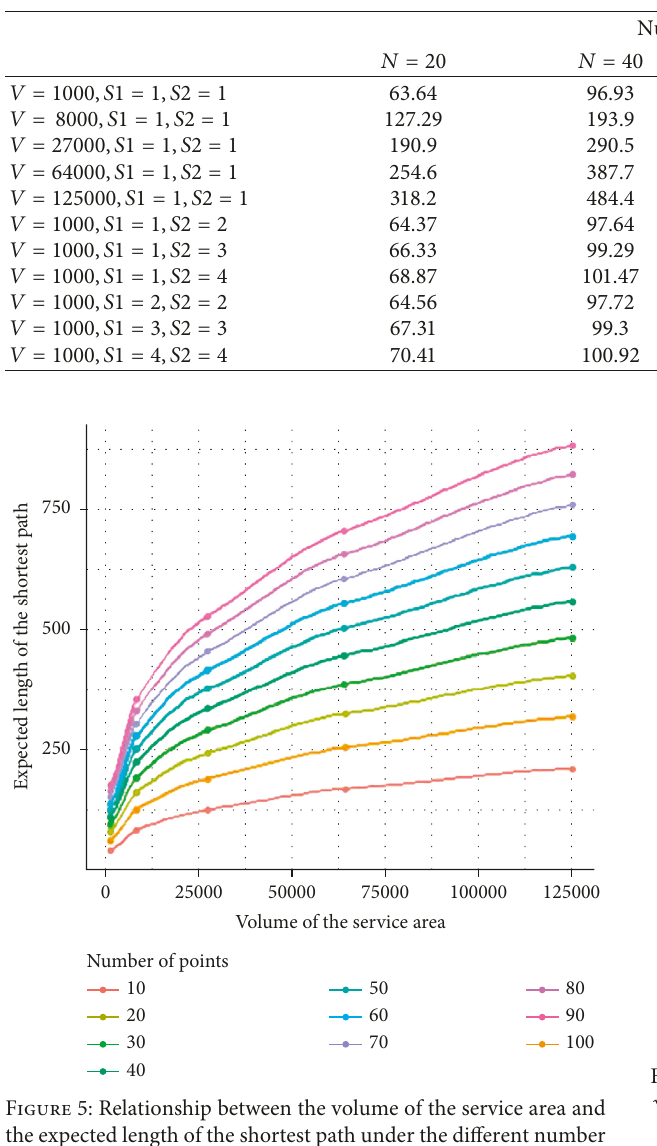
1 ,s 2 1). (cid:31) (cid:31)